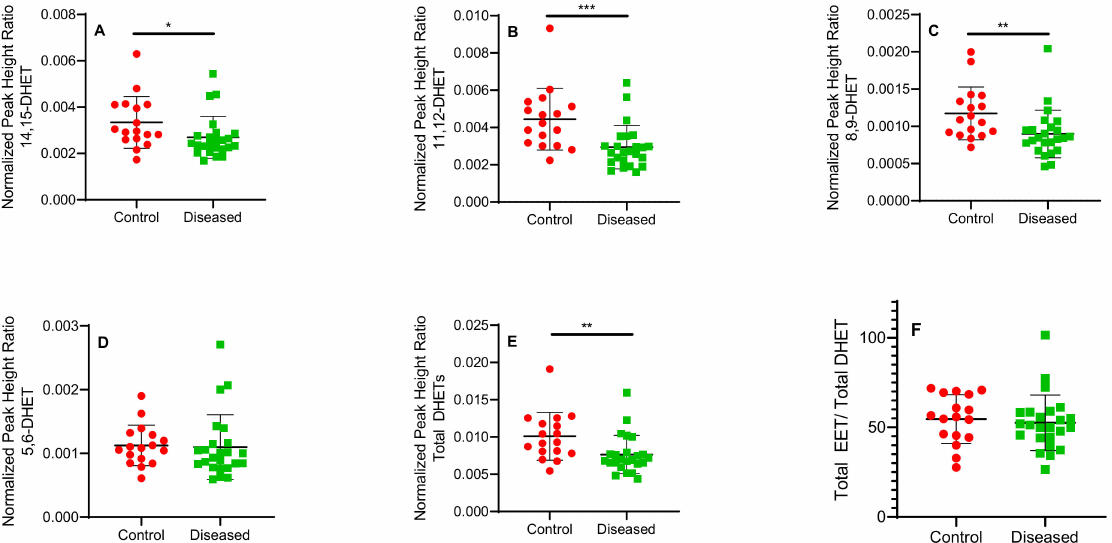
Figure 6. Normalized peak height ratio of each regioisomer of DHETs ( A – E ) and ratio of total cis -EETs to total DHETs ( F ) extracted from control and diseased human cardiac tissue. *** indicates p ≤ 0.001, ** indicates p ≤ 0.01 and * indicates p ≤ 0.05.